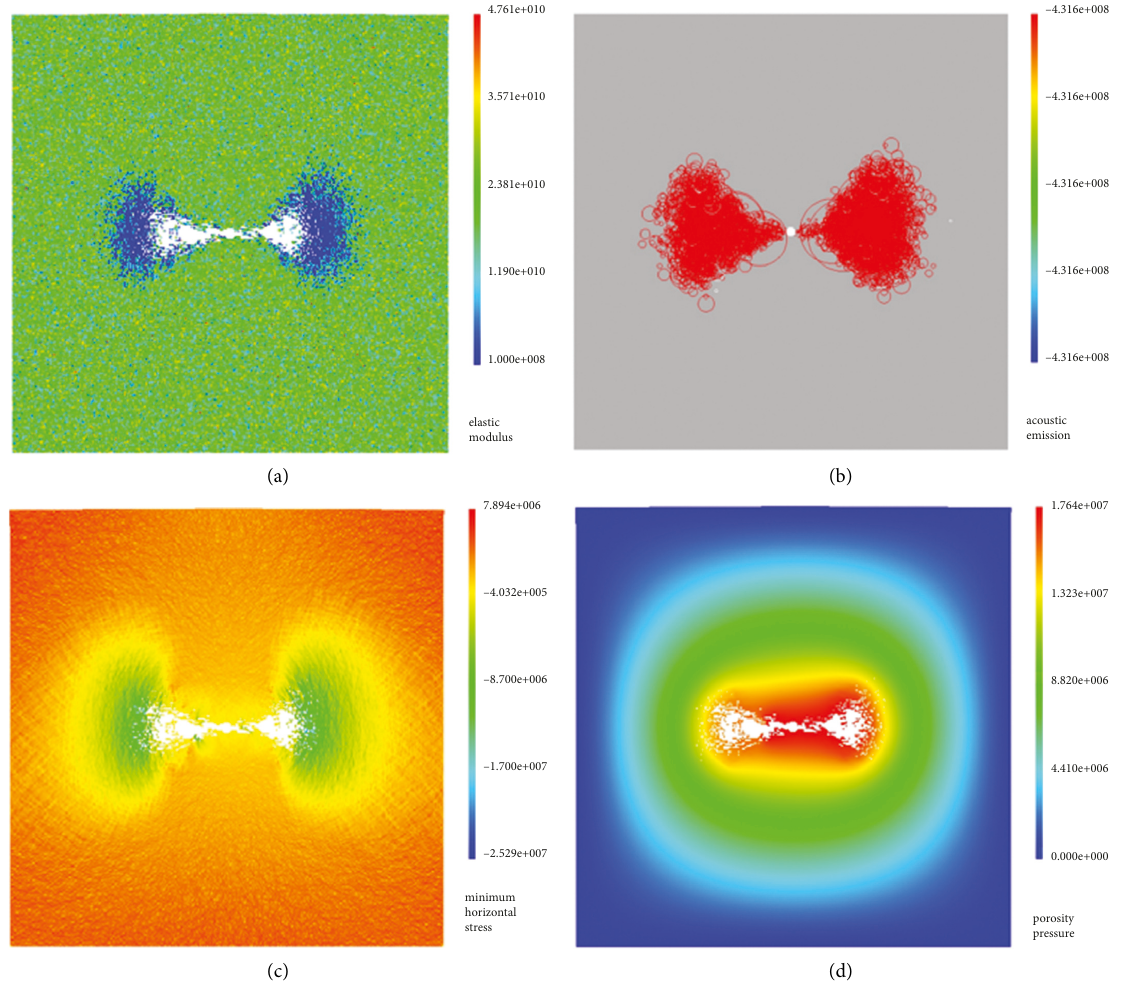
Figure 6: Fracture morphology of medium sandstone fracturing. (a) Elastic modulus. (b) Acoustic emission. (c) Minimum horizontal stress. (d) Porosity